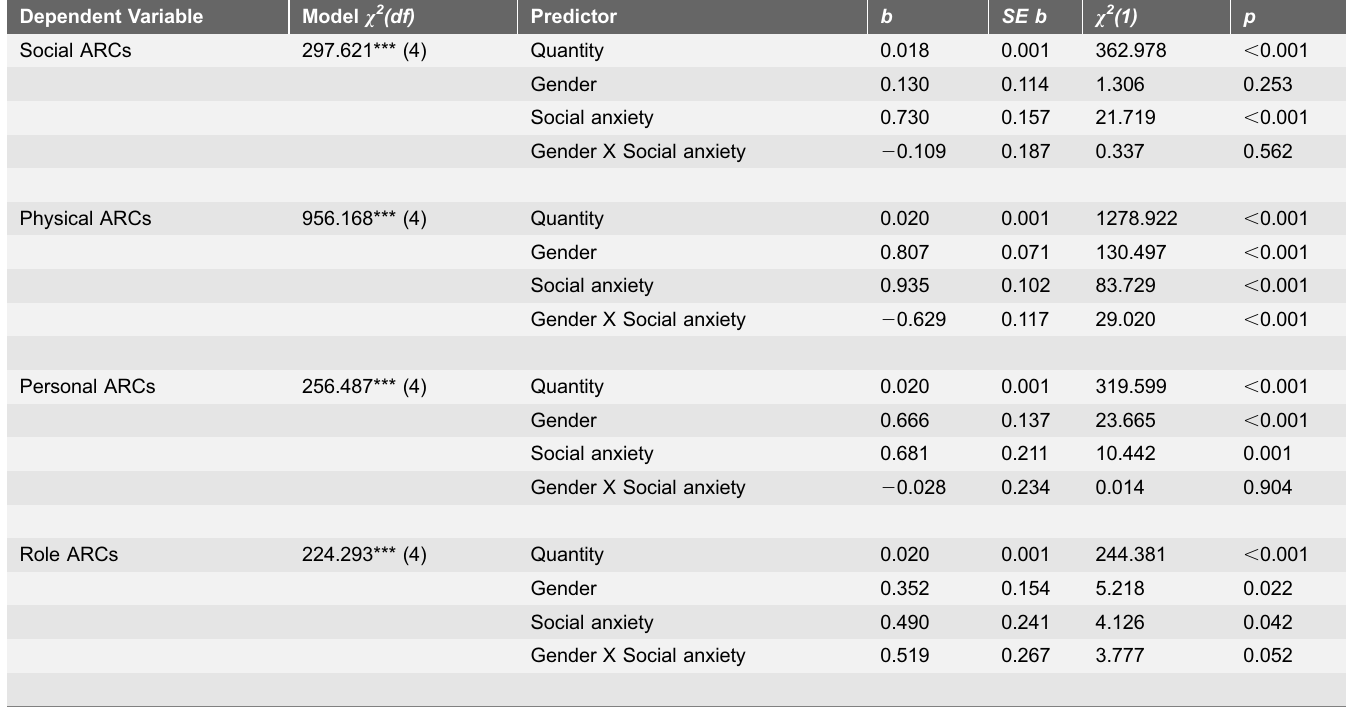
Table 3. Results of poisson regressions using the original factor structure